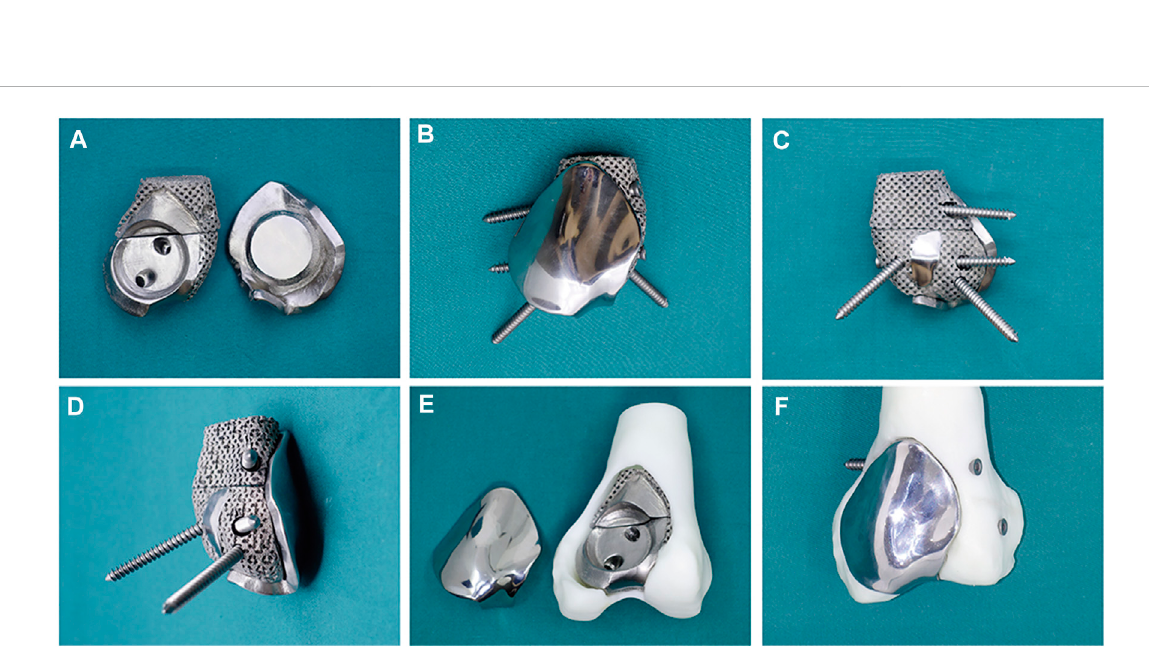
FIGURE 3 (A) The back components (left) combine with the front component (right) through a press- fi t structure. (B) Anterior and (C) posterior and (D) lateral view of the assembled 3D-printed modular prosthesis with four screws. The prosthesis is tested on the femur model before surgery: (E) the back components fi ll in the bone cavity, and (F) the front component is fi xed on the back components and connected to the adjacent articular